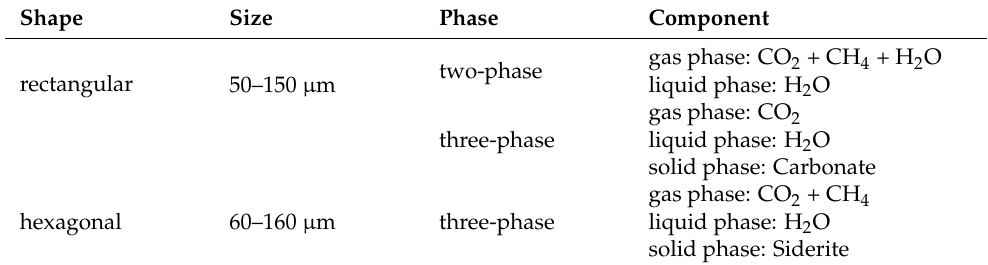
Table 4. Fluid inclusion characteristics and components in Kamakanga emeralds. Shape Size Phase Component rectangular 50–150 µ m